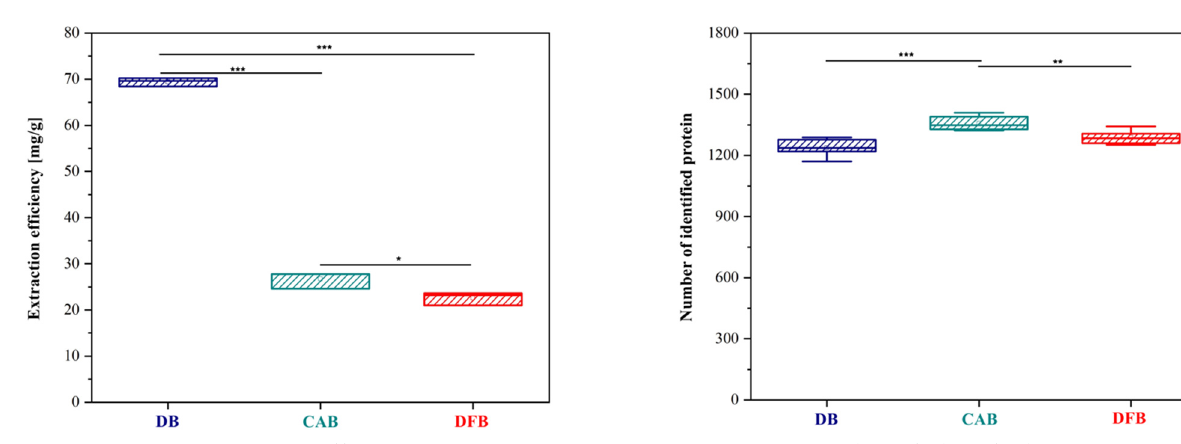
Table 1. Composition of homogenization buffers used in the study.